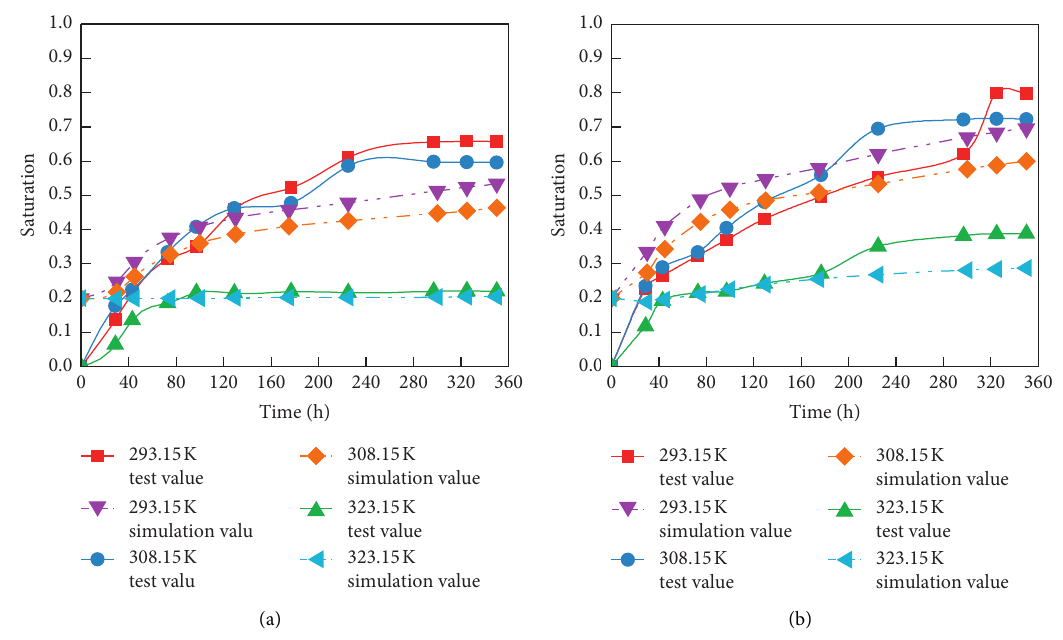
Figure 7: Test and simulation values of moisture absorption process: (a) 80% RH and (b) 95%